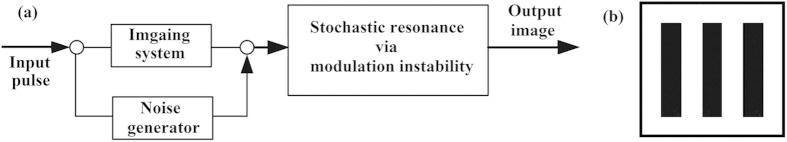
(a) Schematic diagram to reconstruct noise-hidden images of nanosecond pulse via stochastic resonance.(b) The original pure image carried by signal beam.